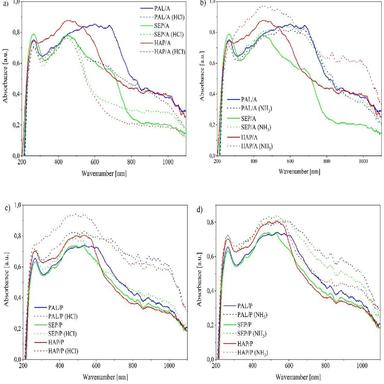
UV–Vis spectra of the hybrid pigments exposed to HCl (a, c) and NH3 (b, d) vapors.